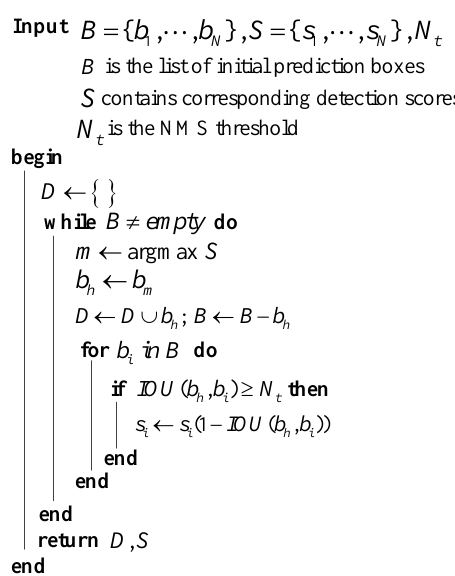
Figure 10. NMS reduces the recall rate of ship detection and causes missed detection.